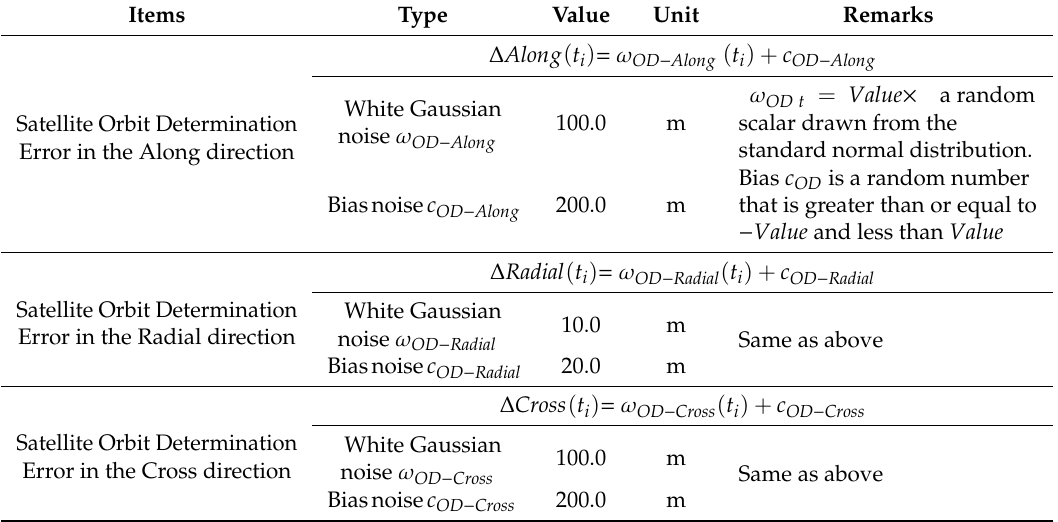
Table 4. Overview of satellite orbit determination error used in the